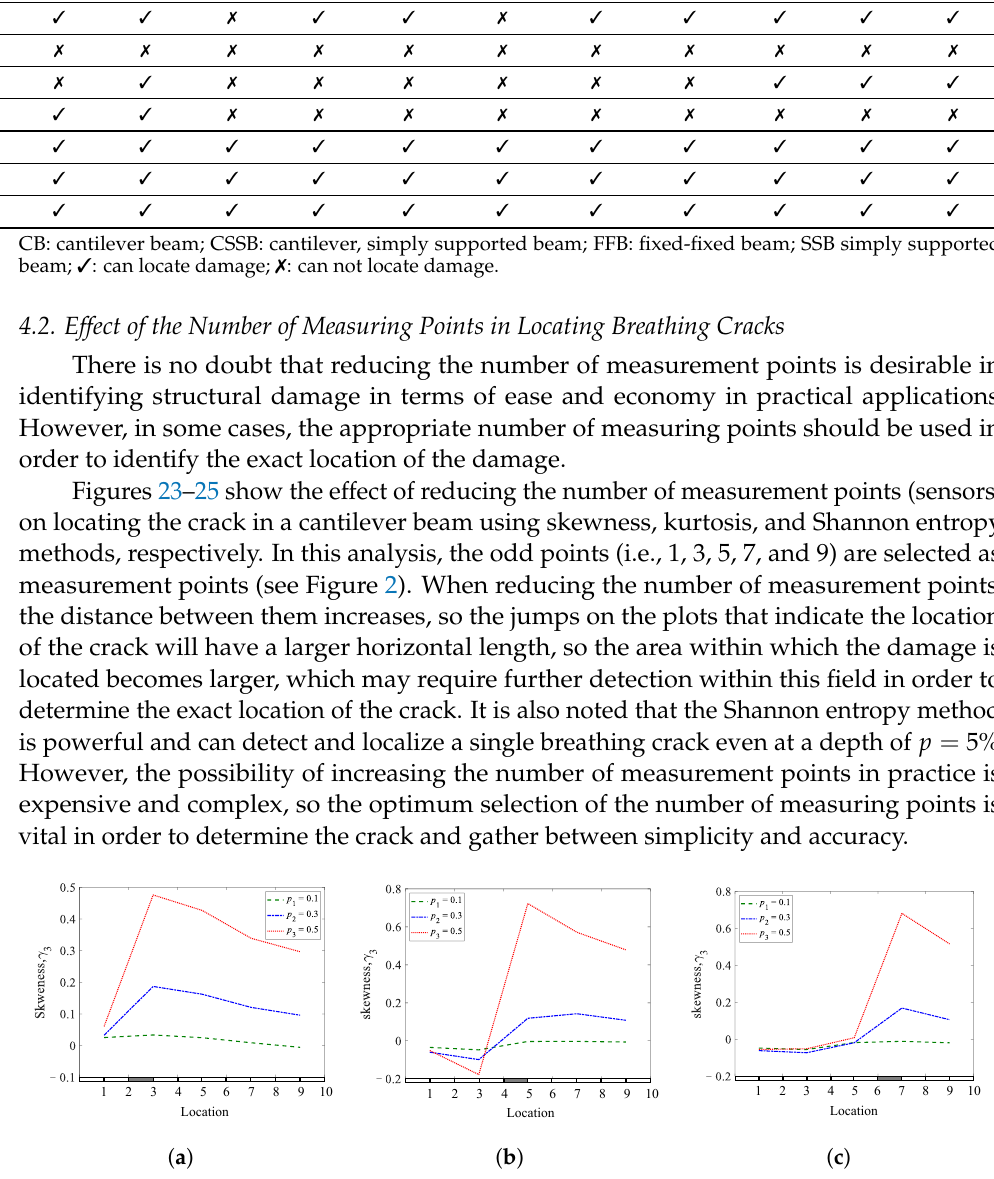
Figure 23. The effect of reducing the number of measurement points (5 points) on damage localiza- tion using skewness coefficients at various crack depths and locations: ( a ) q 1 = 0.25; ( b ) q 2 = 0.45; ( c ) q 3 =